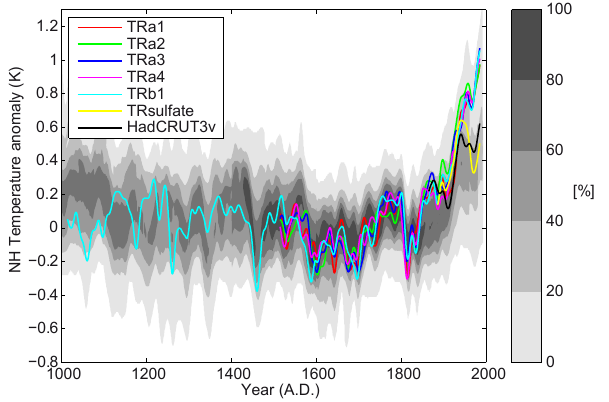
Fig. 2. Annual mean northern hemisphere SAT anomaly from all transient simulations (also including TRsulfate) compared with overlapping northern hemisphere temperature reconstructions over the last millennium (shown by grey shading; Fig. 6.13d IPCC, 2007) and the HadCRUT3v data since 1860. Temperature anomalies are derived from their 1500 to 1899 means, except for the TRsulfate simulation and the HadCRUT3v data. These two time series are ad- justed to have the same mean anomaly for 1870 to 1899 A.D. as the average of the other simulations. All time series are smoothed with a Gaussian-weighted filter to remove fluctuations on time scales less than 30 years.